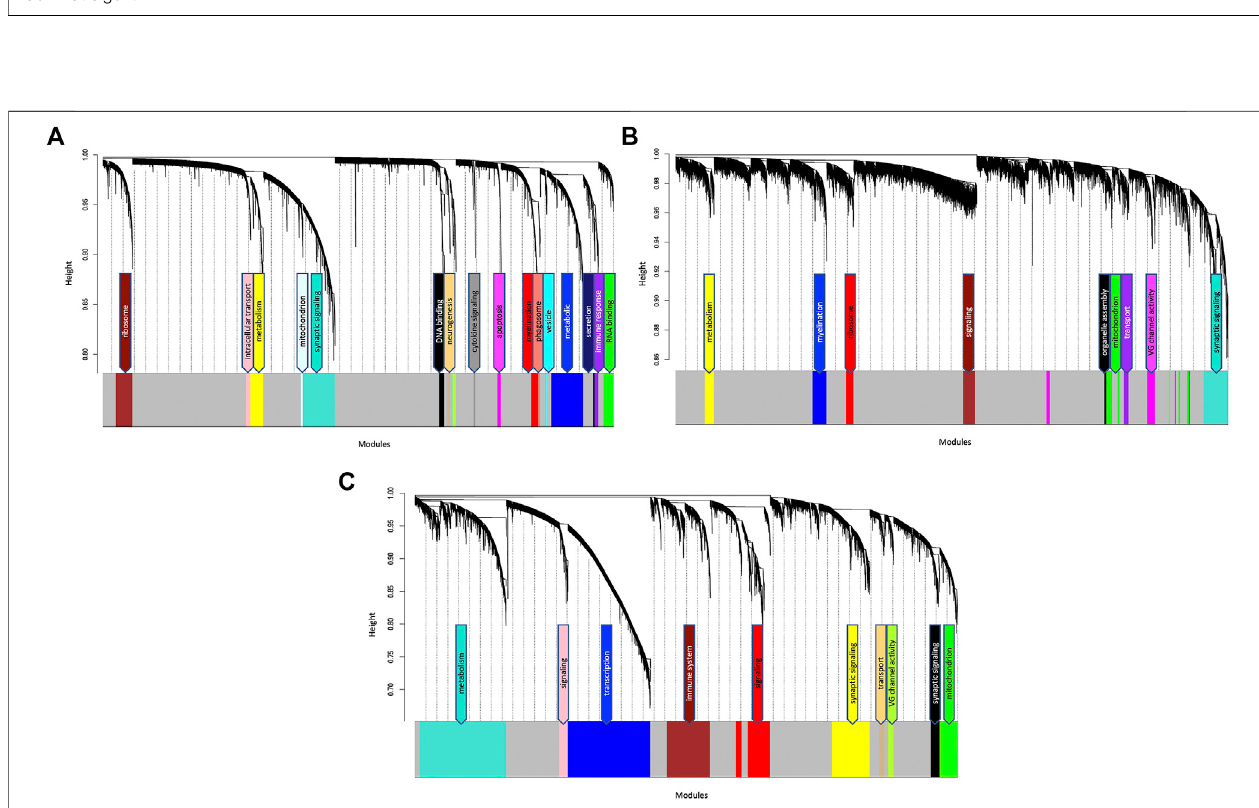
FIGURE 2 | Hierarchical cluster dendrogram of (A) TLE (B) AD and (C) NDC gene coexpression networks. Each black branch (vertical line) corresponds to one gene. The colour rows below the dendrogram indicate module membership. The modules are functionally annotated and named based on the enriched GO/KEGG pathways of the member genes. The grey module contains genes that have no speci fi c module assignment i.e., the expression pattern of these genes does not show suf fi cient variability.